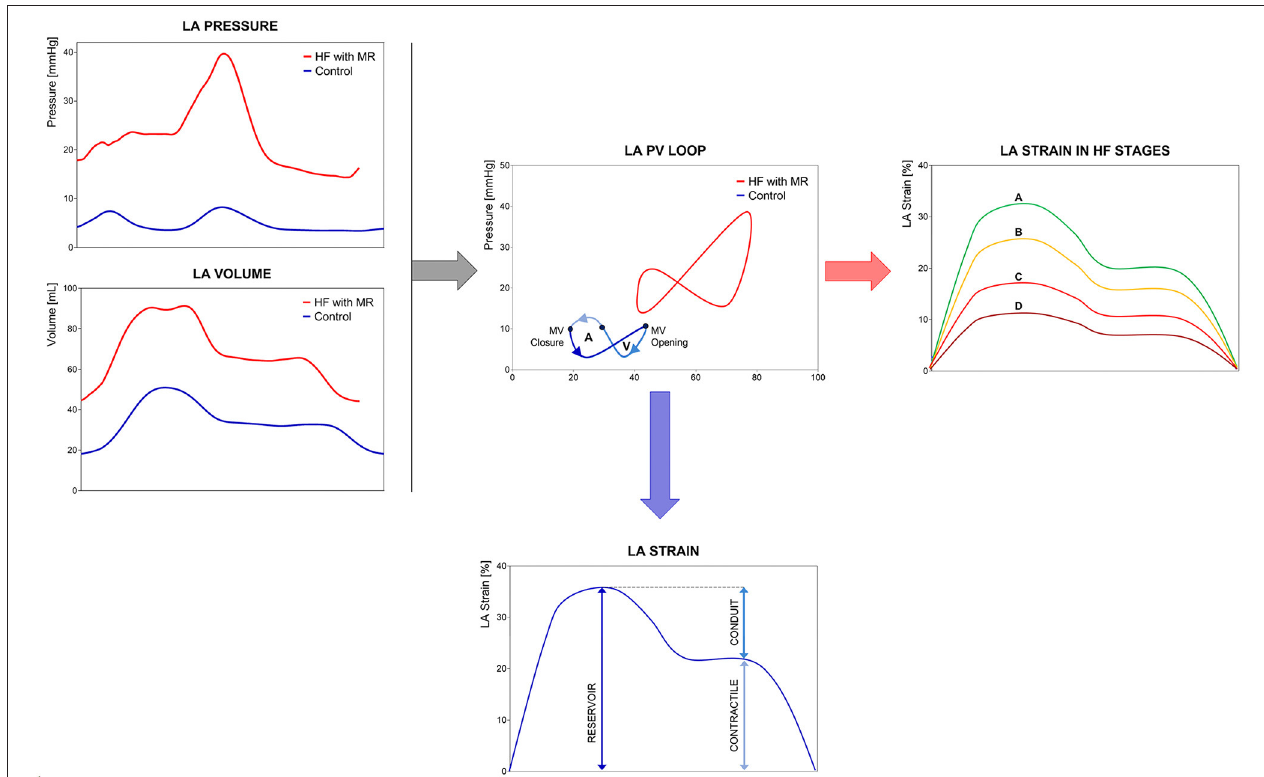
FIGURE 1 | Left Atrium (LA) mechanics and physiology. Comparison of LA mechanics and physiology in a control subject vs. a heart failure with reduced ejection fraction (HFrEF) patient: (left) real LA pressure and volume traces in a control subject and HFrEF patient with severe mitral regurgitation; (center) LA Pressure-Volume loops in the same subjects; (right) representation of progressive LA longitudinal strain decline in the HF stages; (bottom) average LA longitudinal strain with three phasic components. LA pressure-volume (PV) loops show the right- and upward shifting of the loop of HF patient respect to the control subject, with loss of active atrial contraction and MR-related pressure increase. LA longitudinal strain allows the study of chamber phasic function providing physiopathological insights consistent with LA PV loop analysis. Abbreviations as in the